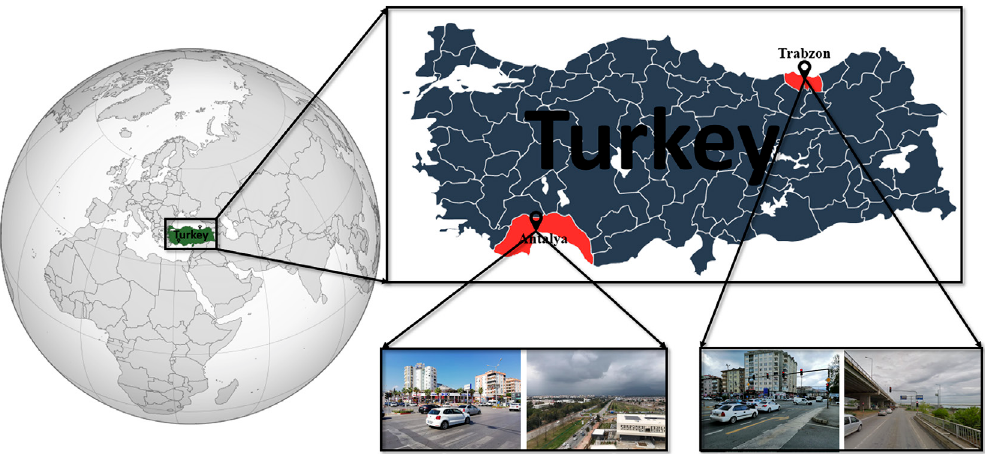
Figure 1. Locations of the two examined cities and some sample visuals from the signalized